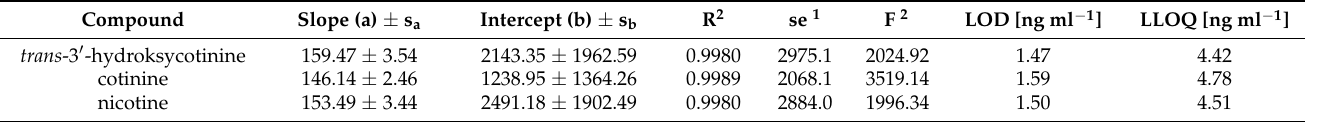
Table 1. The statistical parameters of the calibration curves (y = ax + b).